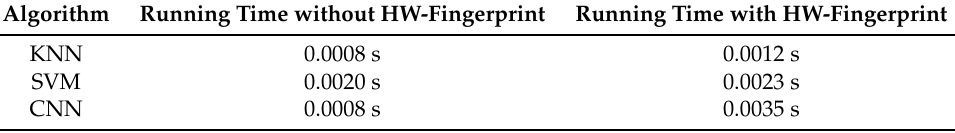
Table 8. Time to test a single